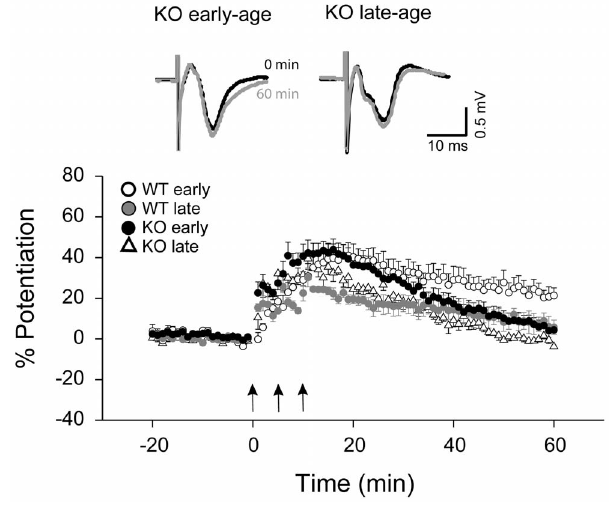
Figure 2. Lack of LTP expression in Fmr1 KO in both early- and late-age windows. Average responses over time are shown for two different age windows (early-age: P16-20, n=6; late-age: P27-31, n=4). Insets show overlapping field potential traces before (black) and 60 min after (gray) LTP induction. Note that there was no significant LTP in early- and late-age groups of Fmr1 KO mice. Arrows indicate three consecutive tetanic stimulations.